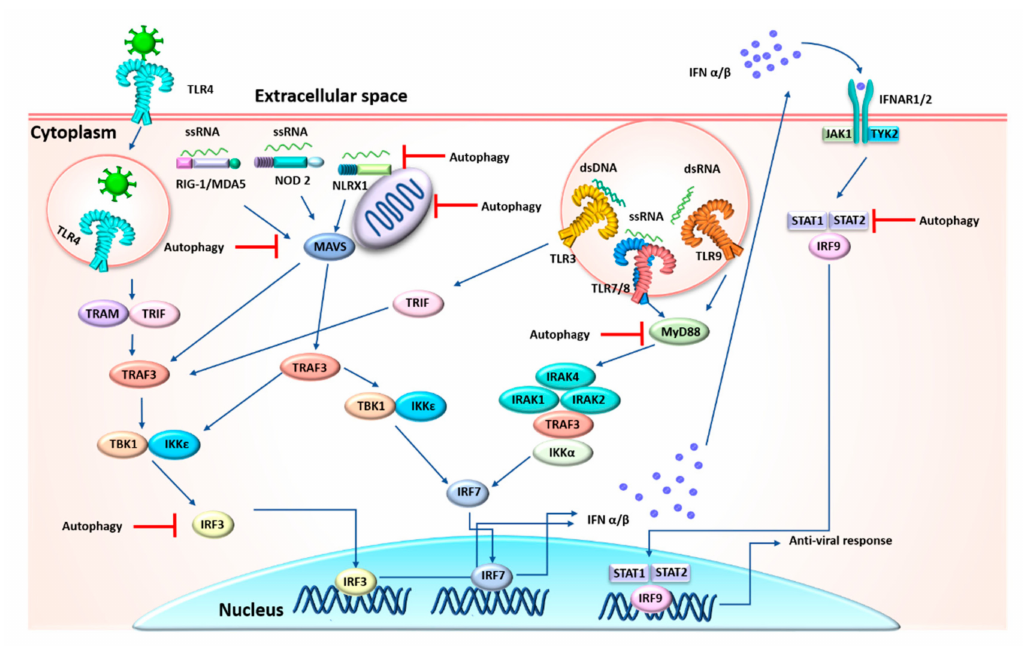
Figure 2. Negative regulation of interferons (IFNs) by autophagy. Upon recognition of viral pathogen- associated molecular patterns (PAMPs) by pattern recognition receptors (PRRs), several signaling pathways are activated to produce IFNs. This response is amplified by the activation of the Janus kinase signal transducer and activator of transcription (JAK-STAT) pathway. Some coronaviruses negatively regulate the IFNs’ response via the autophagic degradation of key molecules downstream of IFN signaling cascade (e.g., IRF3, MAVS, NLRX1, mitochondria, MyD88 and